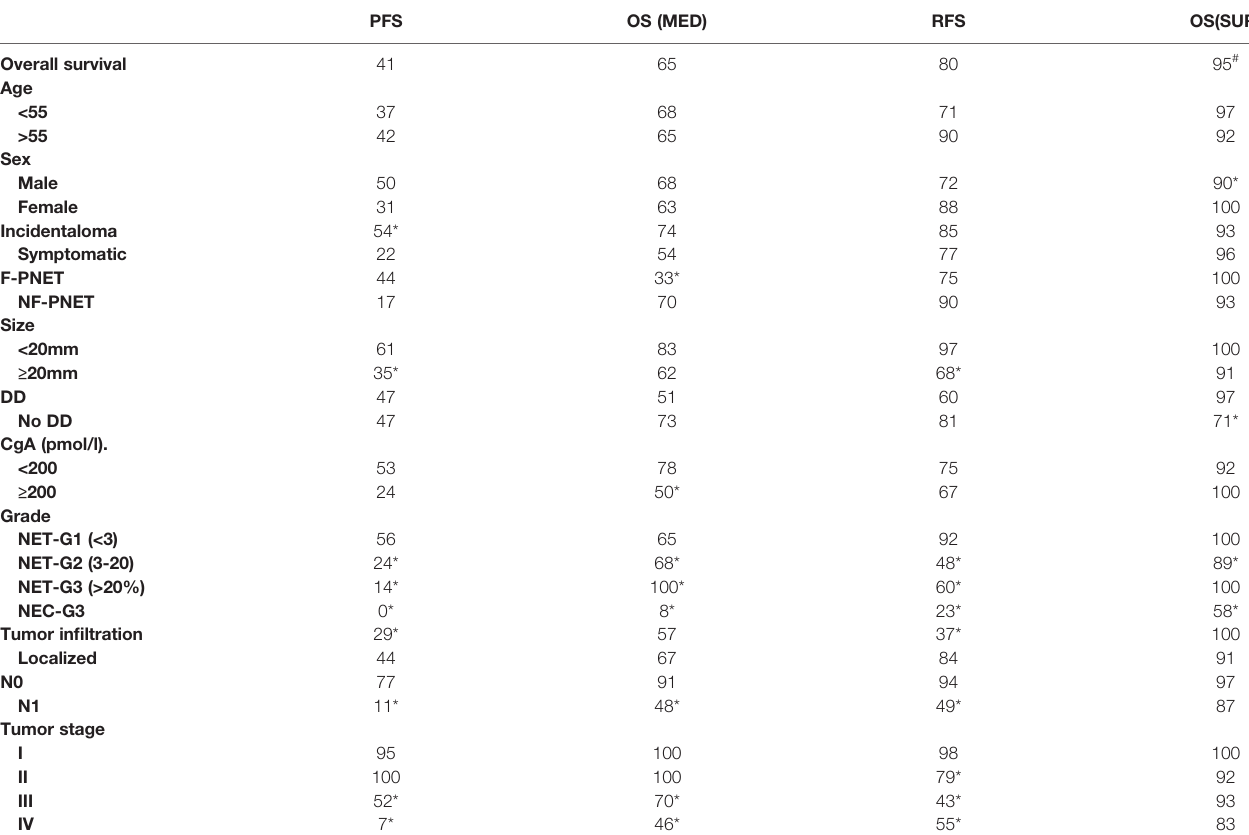
TABLE 2 | Univariate analysis on determinants of mortality and 5-year survival (%) in 174 patients with pancreatic neuroendocrine tumors divided into surgically treated (SUR group, n = 91) and medically treated or non-treated (MED group, n = 83). PFS OS (MED) RFS OS(SUR) Overall survival 41